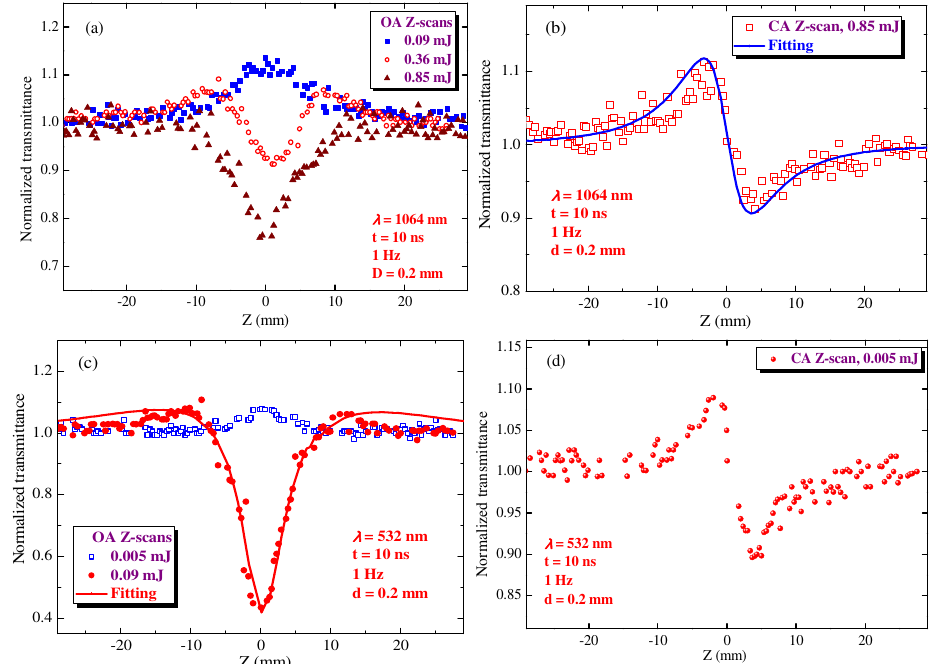
Figure 6. OA ( a , c ) and CA ( b , d ) Z-scans of 0.2 mm-thick HgS QD suspension using 10 ns probe pulses. ( a , b ) 1064 nm probe pulses. ( c , d ) 532 nm probe pulses. The energies of probe pulses are shown on the graphs. Solid curves correspond to the fittings of CA and OA Z-scans.